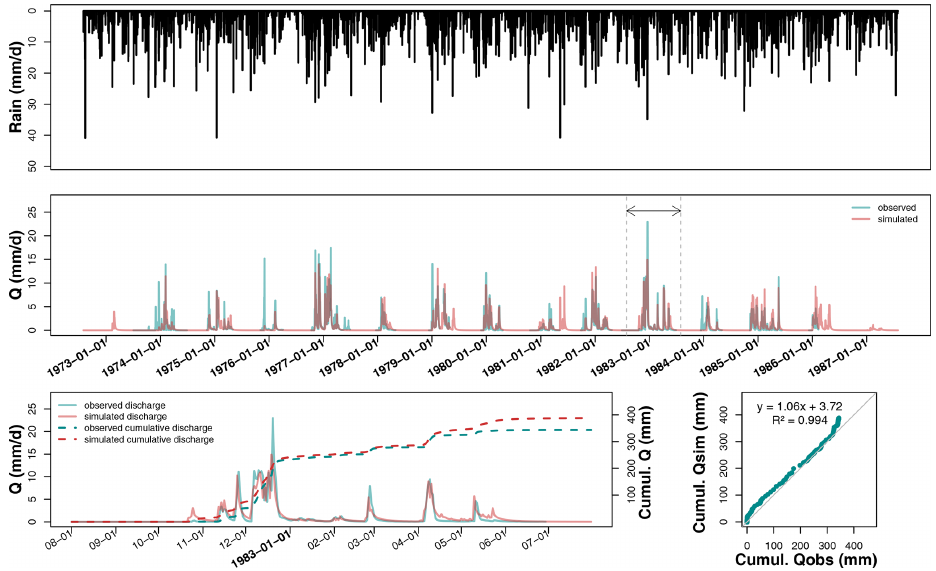
Figure C1. Hydrograph on Saint_Laurent_P2 after calibration over the entire available record, plus a magnified plot of hydrological year 1982–1983 and the associated temporal and direct comparisons between observed (blue curve) and predicted (red curve) cumulative dis- charges.